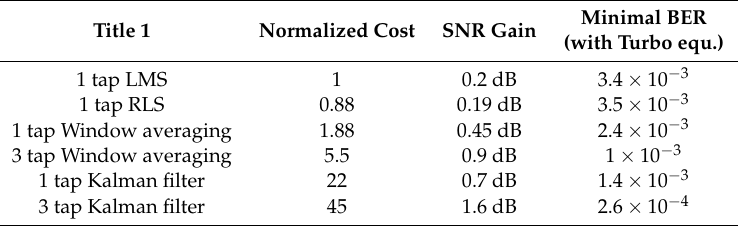
Table 1. Summary of equalization algorithms performance. Note that the minimal BER for the unequalized case is 4.5 × 10 − 3 .